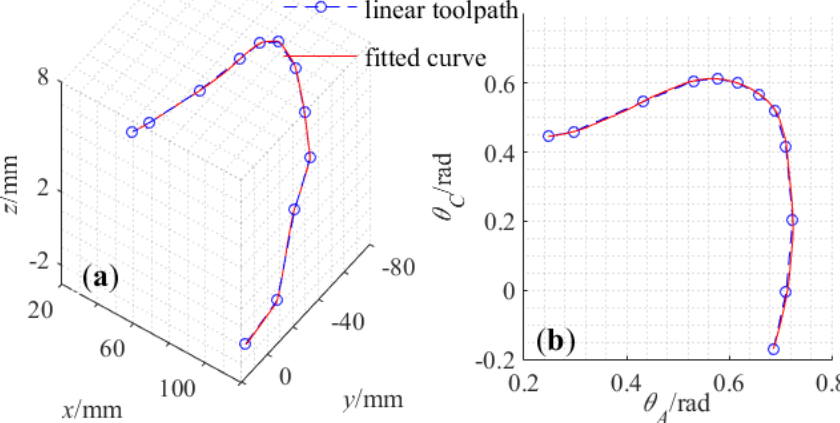
Figure 9. Results of fitted curve for the experimental linear-segment toolpath—( a ) Tool-tip position. ( b ) Tool